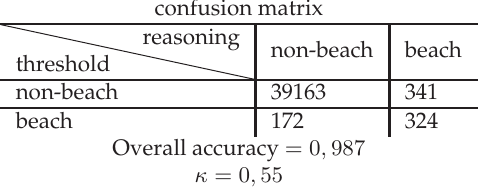
Table 5: Evaluation of ontological detection of beach segments in comparison to expert C classification.